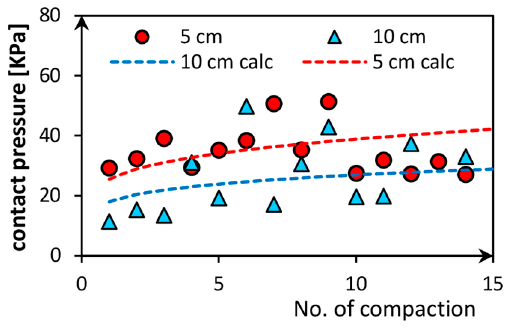
Figure 15. Contact pressure versus the number of compaction falls.